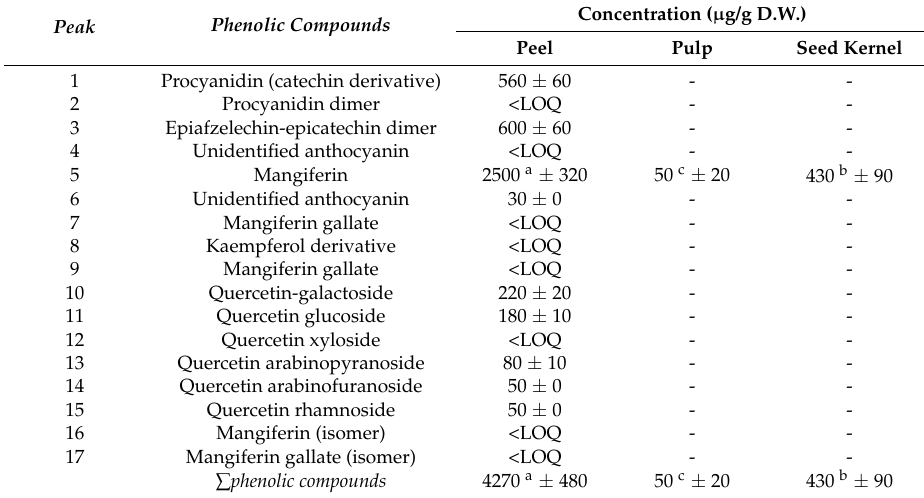
Table 4. Concentration of phenolic composition in mango peel, pulp and seed kernel. Peak Phenolic Compounds